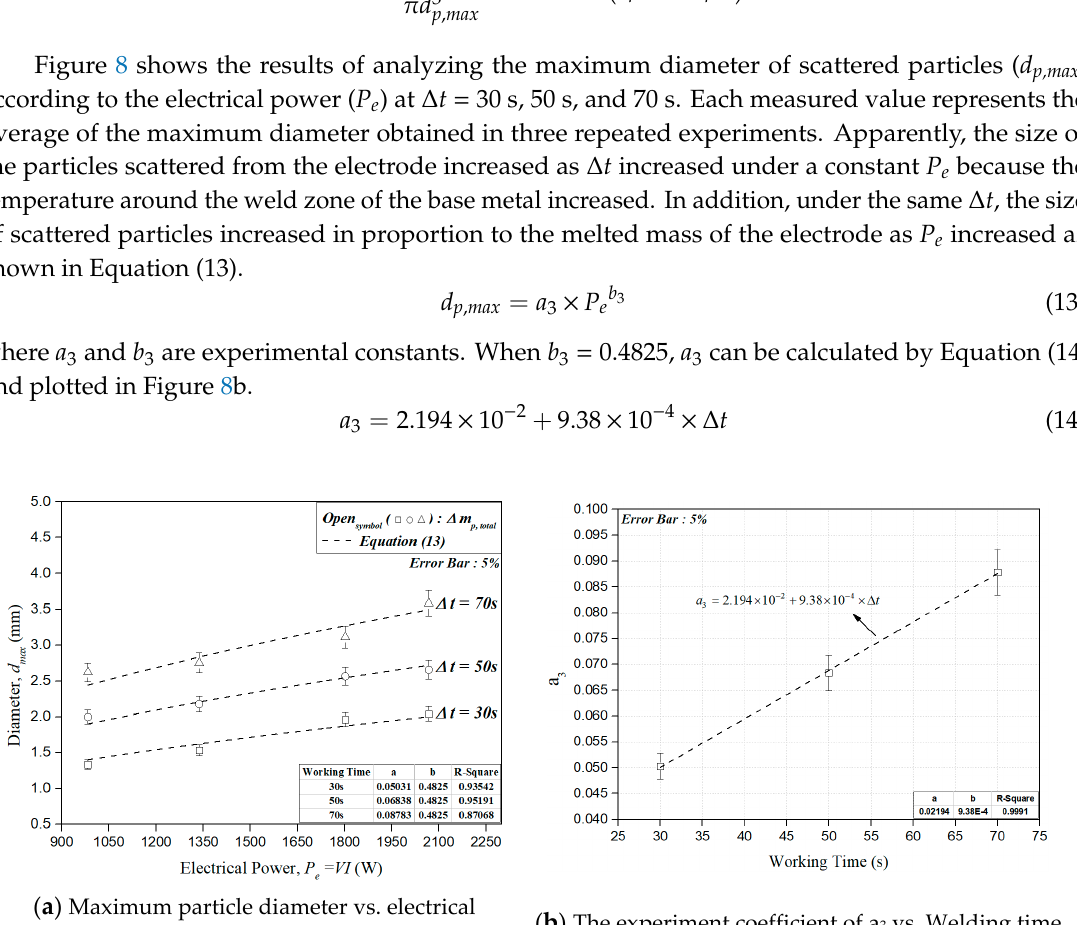
( a ) Maximum particle diameter vs. electrical ( b ) The experiment coefficient of a 3 vs. Welding time power Figure 8. Effects of electrical power on the distribution of the particles and the max diameter of the particles at welding time = 30 s, 50 s, and 70 s.